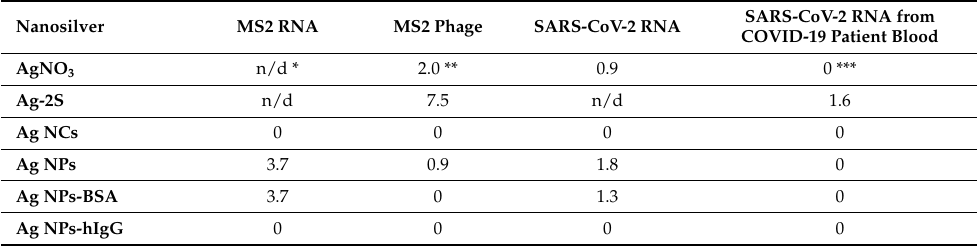
Table 2. Comparison of RNase activity of the silver nanomaterials at equal concentrations 0.1 mg/mL using RT 2